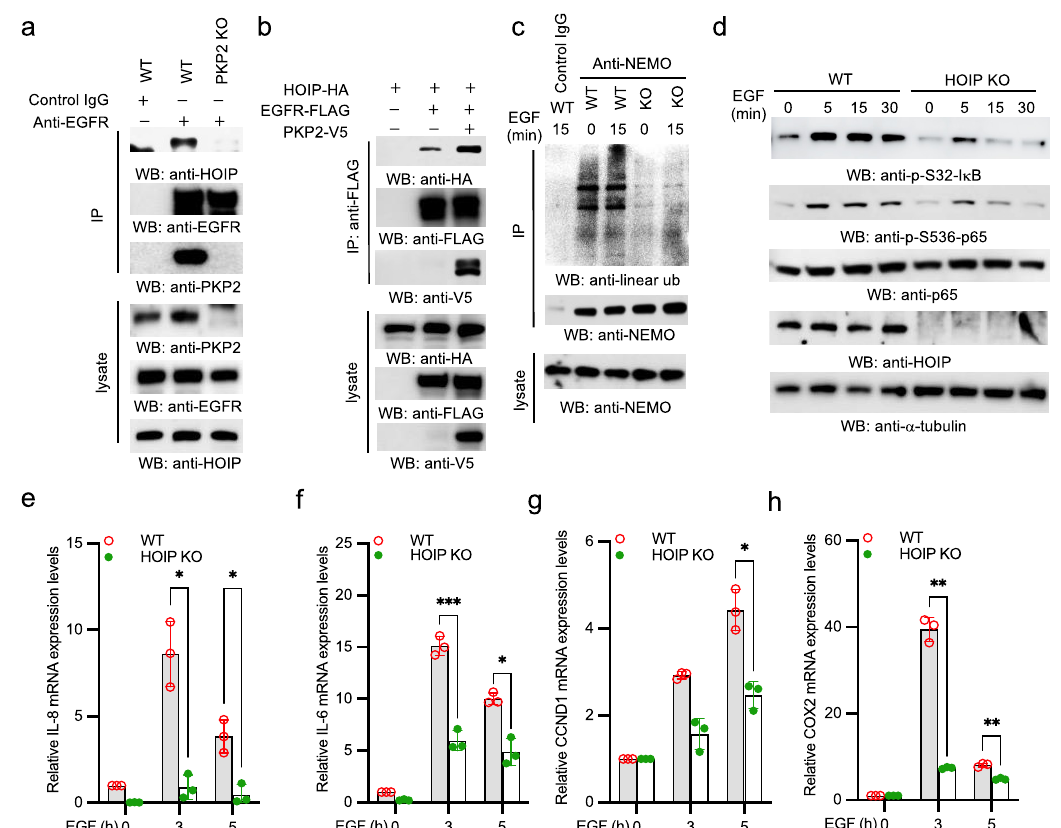
Figure 4. EFGR recruits HOIP and induces linear polyubiquitin-mediated NF- κ B activation. ( a ) PKP2 WT and KO A431 cells were stimulated with 5 ng/mL EGF for 30 min. Cell lysates were immunoprecipitated with an anti-EGFR antibody or control IgG and blotted as indicated. ( b ) EGFR, HOIP, and PKP2 were transfected in the indicated combination into HEK293 cells. After 48 h, cell lysates were immunoprecipitated with an anti-FLAG antibody and blotted as indicated. ( c ) HOIP WT and KO A431 cells were stimulated with 5 ng/mL EGF for designated times. Cell lysates were immunoprecipitated with an anti-NEMO antibody or control IgG and blotted as indicated. ( d ) HOIP WT and KO A431 cells were stimulated with 5 ng/mL EGF for designated times. Cell lysates were blotted as indicated. ( e – h ) HOIP WT and KO A431 cells were stimulated with 5 ng/mL EGF for indicated times. Real-time PCR was performed to determine the relative mRNA levels of IL-8 ( e ), IL-6 ( f ), CCND1 ( g ), and COX2 ( h ). All experiments were biologically repeated three times. Data represent means ± s.d. of three independent experiments. The p -value was calculated by two-way ANOVA followed by Sidak’s multiple comparisons test (* p < 0.05, ** p < 0.01, *** p < 0.001).